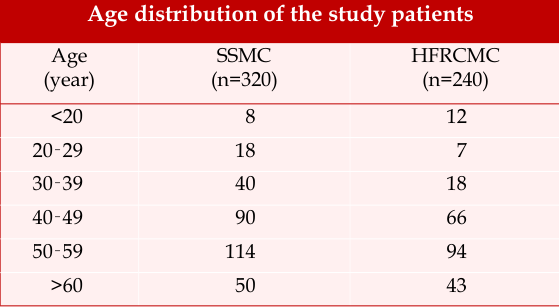
Age distribution of the study